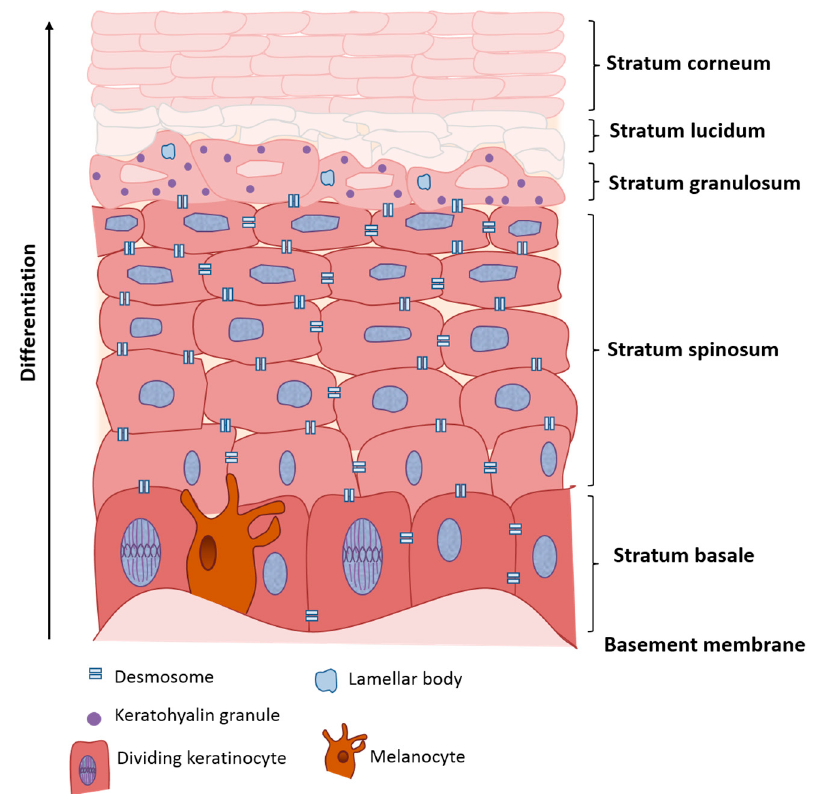
Figure 1. Representative diagram of the epidermis. The basement membrane, separating the dermis from the epidermis, and the distinct strata are indicated.